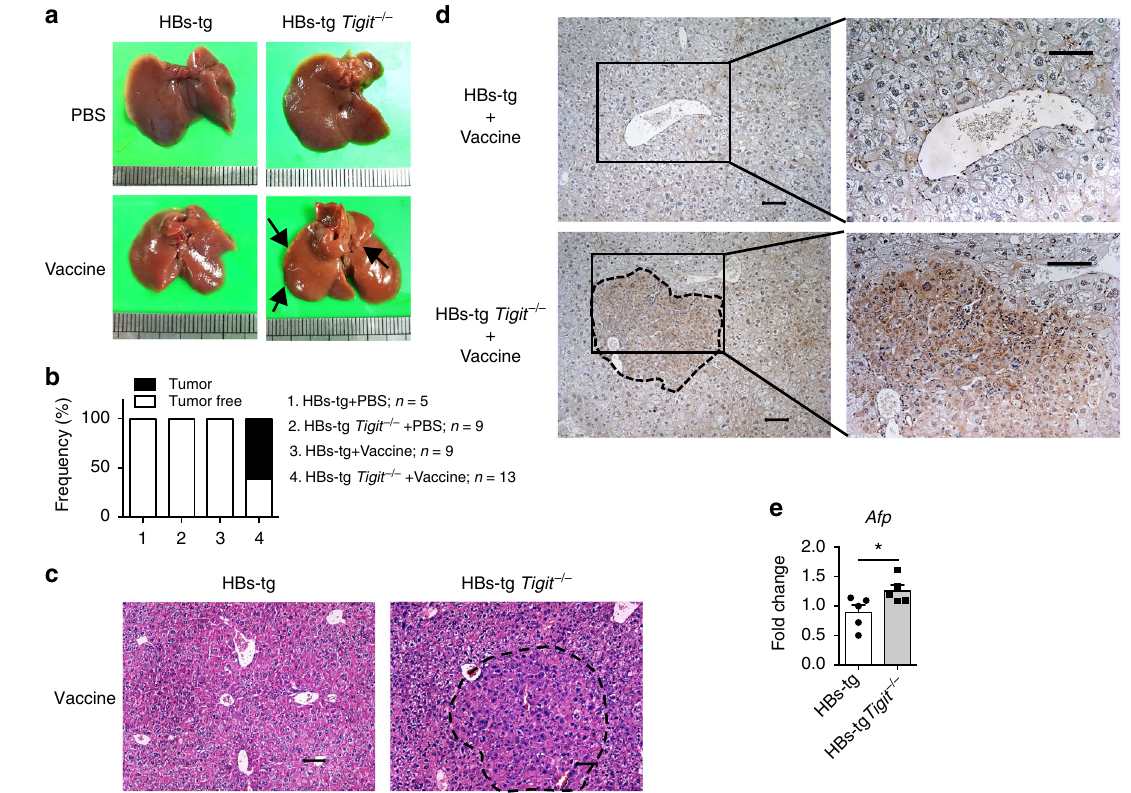
Fig. 3 HBs-tg Tigit − / − mice develop HCC following HBsAg vaccination. a – c 6-month-old HBs-tg Tigit − / − mice and control HBs-tg mice were intramuscularly injected with 1 μ g HBsAg vaccine or 50 μ l PBS biweekly with consecutive repetitions. All mice were harvested 2 months after the fi nal vaccination. a Representative pictures of the liver are shown. Black arrows indicate tumor nodules. b The percentage of mice with tumorigenesis was calculated. Data are pooled from three independent experiments. c H&E staining of liver tissue sections from vaccinated HBs-tg and HBs-tg Tigit − / − mice. Scale bar, 50 μ m. d Representative images showing immunohistochemical AFP staining of paraf fi n-embedded liver sections from vaccinated HBs-tg and HBs-tg Tigit − / − mice. The right pictures show the magni fi ed views of the areas indicated by the squares in the left pictures. Scale bars, 50 μ m. e Quantitative RT-PCR analysis of hepatic Afp gene of vaccinated HBs-tg and HBs-tg Tigit − / − mice ( n = 5 in each group). Statistically signi fi cant differences between the groups are presented as the mean ± SEM. * P < 0.05 (two-tailed unpaired Student ’ s t -test). Data are representative of two